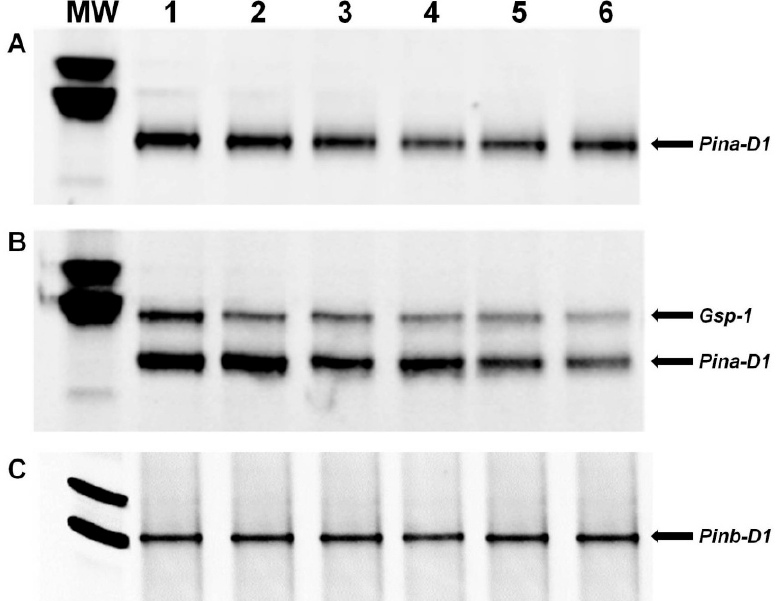
Figure 2. ( A ) Pina-D1 amplification with primer LIL1; ( B ) Pina-D1 amplification with primer MAS; ( C ) Pinb-D1 amplification with primer LIL2. Lanes represent as follows: ( 1 ) cv. Chinese Spring (Pina-D1a/Pinb-D1a ); ( 2 ) CWI 67429; ( 3 ) CWI 57816; ( 4 ) CWI 67483; ( 5 ) CWI 73046; and ( 6 ) CWI 72689.